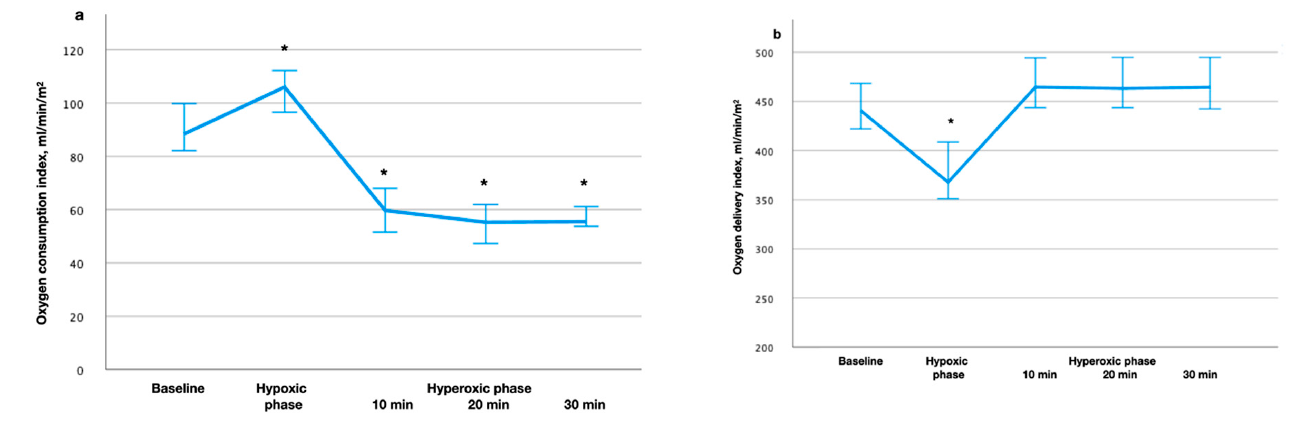
Figure 2. The dynamics of oxygen consumption ( a ) and oxygen delivery ( b ) indices during the hypoxic–hyperoxic preconditioning. *— p < 0.05 comparing to the baseline. Table 4. Characteristics of endothelin-1, nitric oxide metabolites, and ADMA concentrations in the perioperative